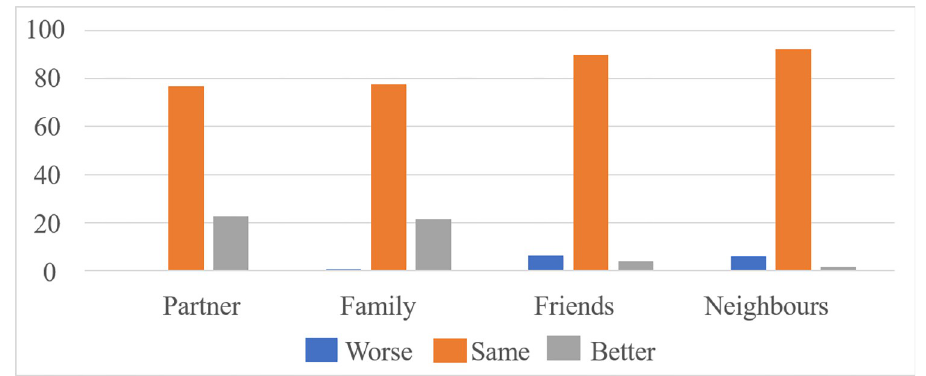
Fig 1. Percentage relationship change since COVID-19, by relationship type.